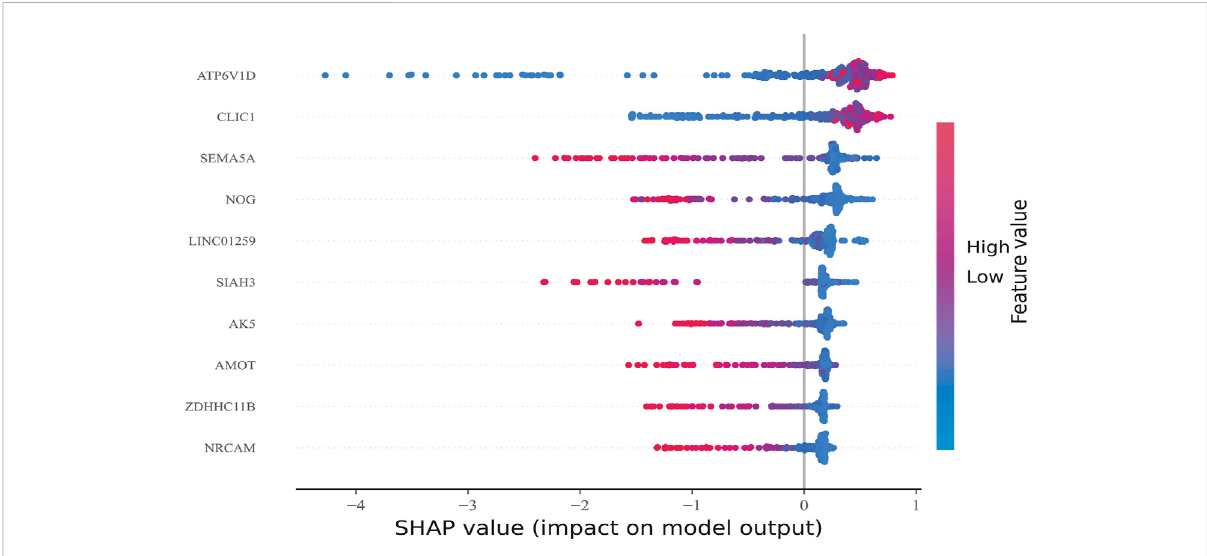
FIGURE 6 Feature Sorting: Distinguishing feature values. The vertical axis shows ranked features according to the sum of the SHAP values of all samples, and the horizontal axis indicates the SHAP value (the distribution of the in fl uence of the features on the model output). Each point represents a sample, the sample size was stacked vertically, and the color represents the feature value (red and blue correspond to high and low values, respectively). Taking the fi rst row as an example, we observed that high ATP6V1D (red) had a positive impact on prediction, and low ATP6V1D (blue) had a negative impact on